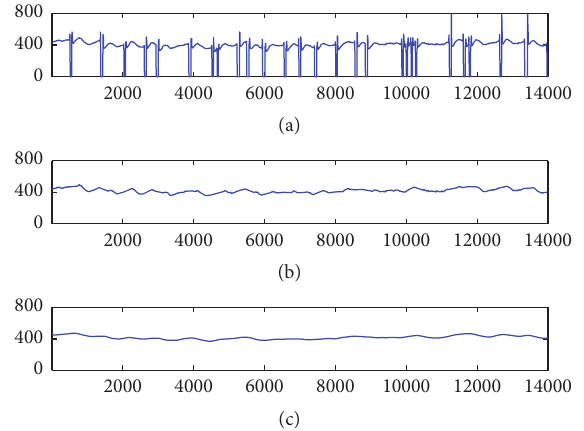
Figure 3: (a) The raw pupil size data. (b) The pupil size data after linear interpolation. (c) The pupil size data after interpolation and smooth.